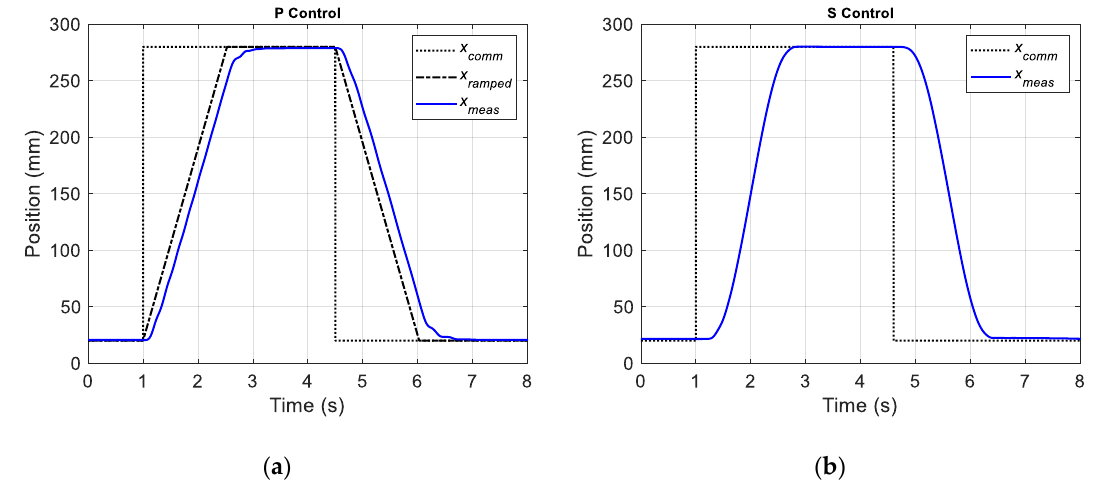
Figure 4. Examples of lifting and lowering cycles used in measurements: ( a ) P-control and ( b ) S- control.